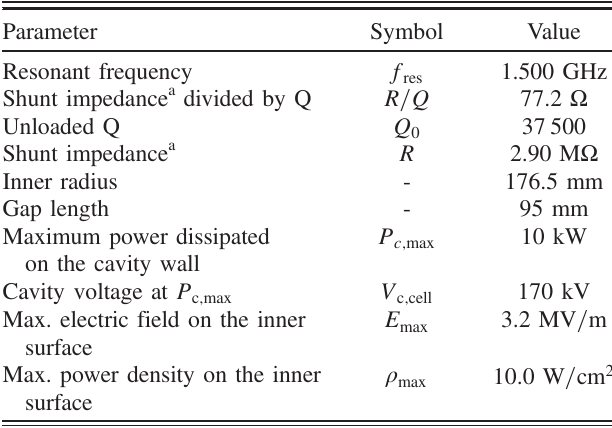
TABLE I. Principal parameters of the TM020 cavity which were assumed for our